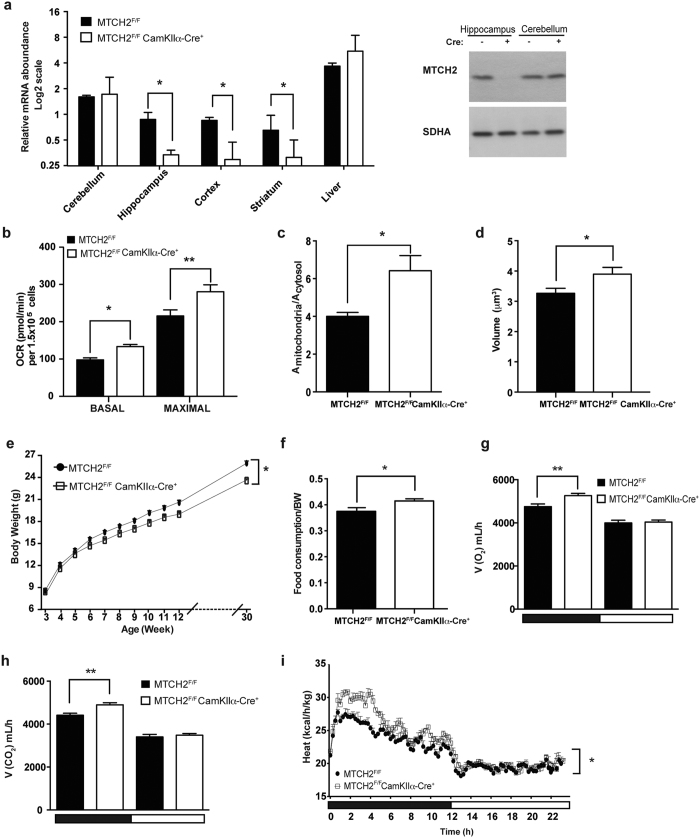
MTCH2F/FCamKIIα-Cre+ mice display increased mitochondria and whole-body energy metabolism.(a) Specific MTCH2 knockout in the forebrain. Left panel: relative gene expression evaluated by real-time PCR (normalized to HPRT expression) using lysates from cerebellum, hippocampus, cortex, striatum, and liver of MTCH2F/Fand MTCH2F/FCamKIIα-Cre+ mice. Results are presented as mean relative expression ± SEM (*p ≤ 0.05, n = 3 mice). Right panel: Western blot analysis using anti-MTCH2 Abs of lysates prepared from hippocampus and cerebellum of MTCH2F/F and MTCH2F/F
CamKIIα-Cre+ mice. Succinate Dehydrogenase A (SDHA) served as loading control. (b) Loss of forebrain MTCH2 increases oxygen consumption. Normalized average of oxygen consumption rate (OCR) measured in real-time indicating basal and maximal respiration rates in XF media containing 10 mM Pyruvate (as indicated by OCR before and after injection of FCCP). The data represent mean ± SEM (*p ≤ 0.05; **p ≤ 0.01) of 4 independent experiments. (c) Mitochondrial area is increased in the soma of MTCH2F/FCamKIIα-Cre+ neurones. The data represent mean ± SEM (*p ≤ 0.05; n = 3 mice/each genotype; n = 40 neurons/each mouse). (d) Mitochondria volume is increased in axons and dendrites lacking MTCH2. Morphometric analysis of 3D reconstructed mitochondria of neurons transfected with MitoDsRed. Total volumes of axonal mitochondria of MTCH2F/F and MTCH2F/F
CamKIIα-Cre+ primary hippocampal neurons are shown. The data represent mean ± SEM (*p ≤ 0.05, 3 independent experiments, 30 fields). (e) MTCH2F/F
CamKIIα-Cre+ mice gain less weight on chow diet. The weight gain of the MTCH2F/F and MTCH2F/F
CamKIIα-Cre+ littermate mice fed on chow diet for 30 weeks are presented. The data represent mean ± SEM (*p ≤ 0.05, n = 12–35 mice; Two-way ANOVA). (f) MTCH2F/F
CamKIIα-Cre+ mice eat more on chow diet. Sum of 24 h food intake measured while housed in the metabolic cages. The data represent mean ± SEM (*p ≤ 0.05, n = 8 mice). (g) MTCH2F/F
CamKIIα-Cre+ mice show increased oxygen consumption. The data represent mean ± SEM (**p ≤ 0.01, n = 8 mice). The light and dark cycles are denoted by horizontal white and black bars, respectively. (h) MTCH2F/F
CamKIIα-Cre+ mice show increased CO2 production. The data represent mean ± SEM (**p ≤ 0.01, n = 8 mice). The light and dark cycles are denoted by horizontal white and black bars, respectively. (i) MTCH2F/F
CamKIIα-Cre+ mice show increased heat production. The data represent mean ± SEM (*p ≤ 0.05, n = 8 mice). The light and dark cycles are denoted by horizontal white and black bars, respectively.